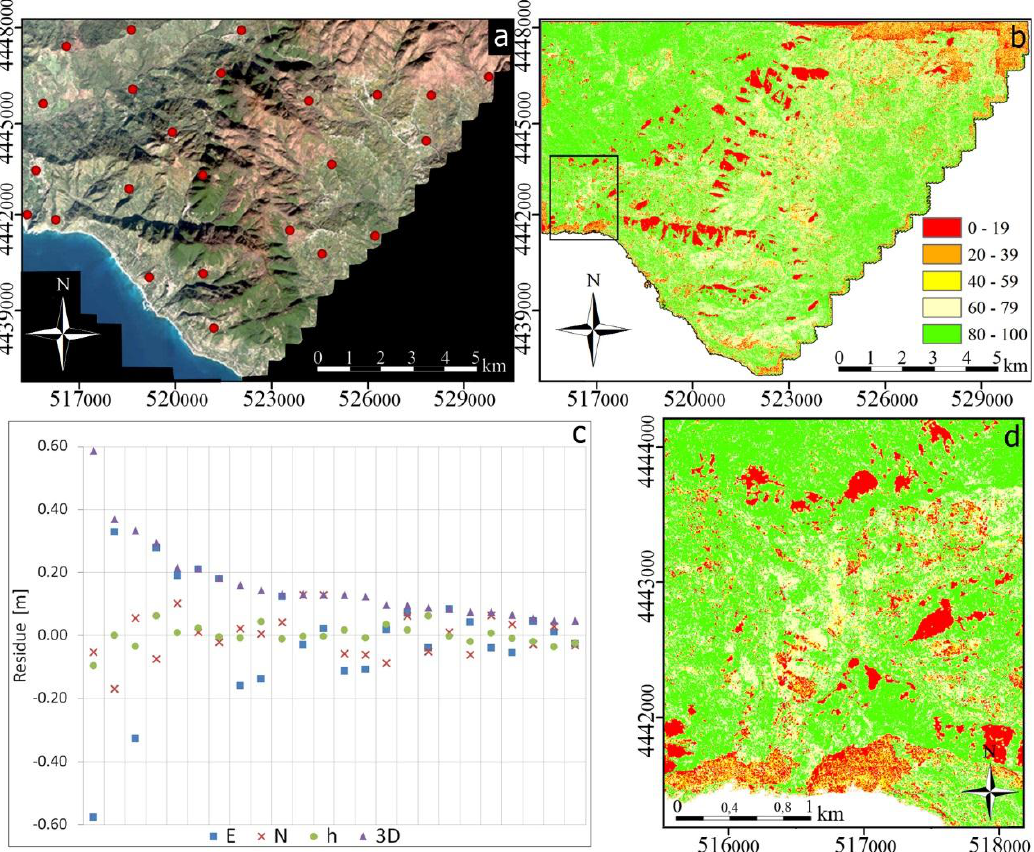
Figure 3. ( a ) GCP location on the GeoEye-1 image represented in the pan-sharpened mode. ( b ) FOM representing the correlation value for each DEM pixel. ( c ) Residuals on the GCPs of the image georeferencing using the rigorous simultaneous math model. ( d ) Zoomed view of the area affected by the landslide.